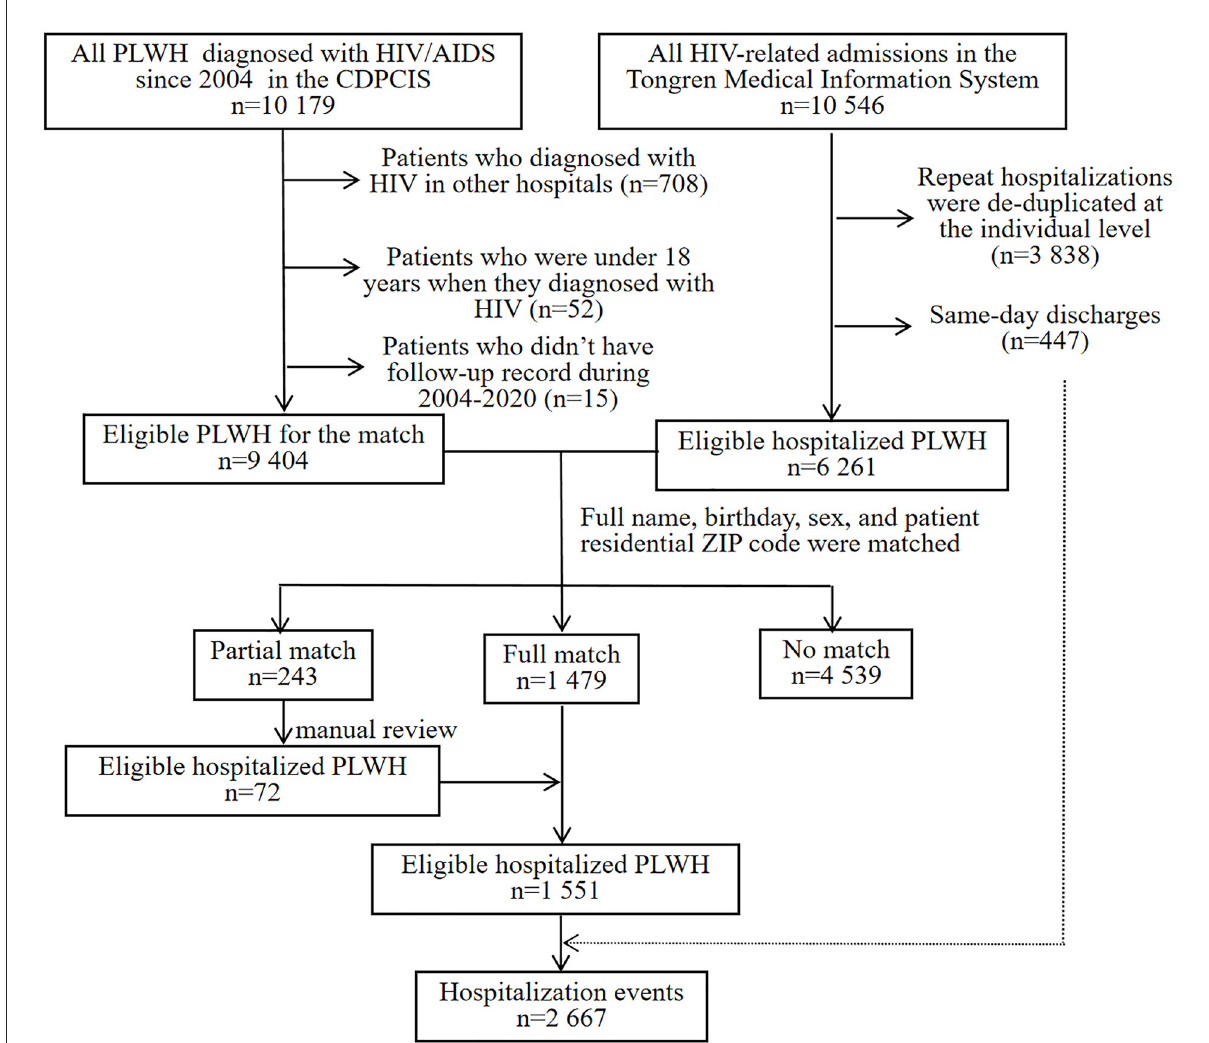
FIGURE1 CDPCIS data and Tongren Medical Information System data set match process. HIV, human immunodeficiency virus; AIDS, acquired immune deficiency syndrome; PLWH, people living with HIV; CDPCIS, China Disease Prevention and Control Information System.